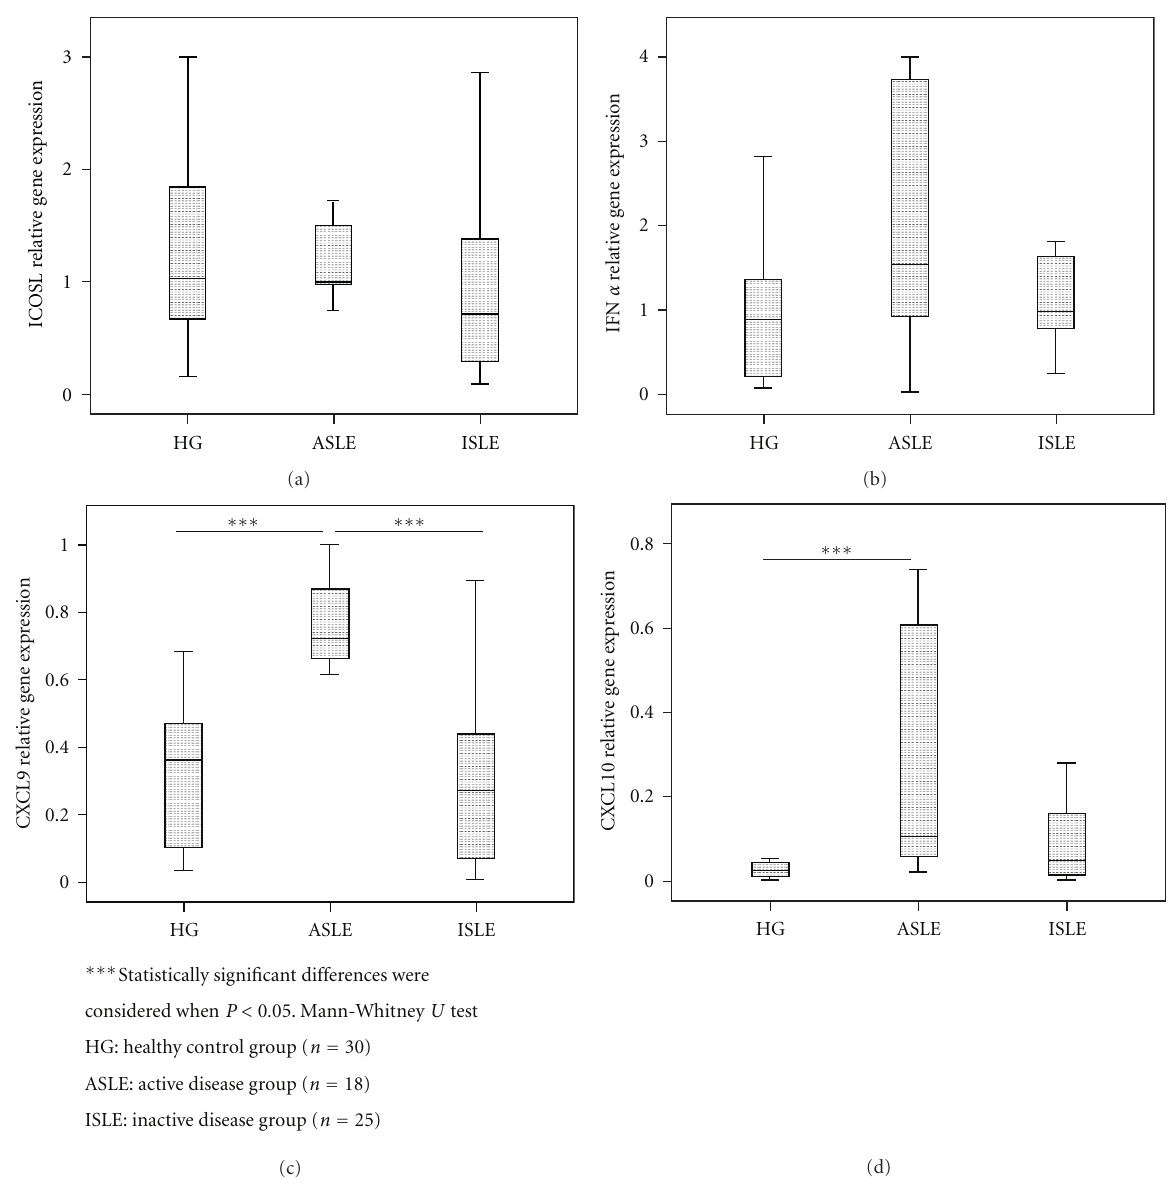
Figure 3: IFN- α , ICOSL, CXCL9, and CXCL10 relative gene expression in cell-sorted CD14 − / low CD16 + DCs subset in the three studied groups (HG, ASLE, and